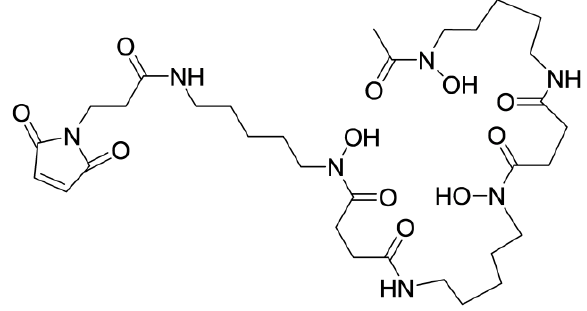
Figure 12. Structure of the deferoxamine (DFO)-maleimido derivative.